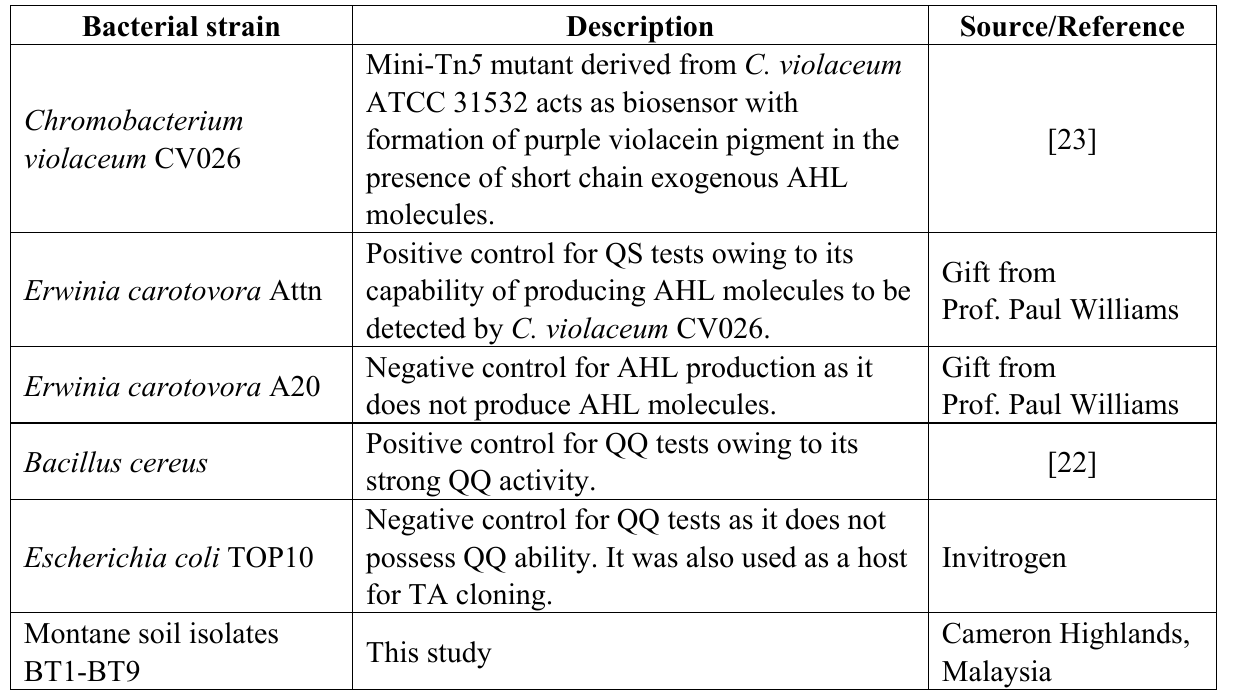
Table 1. Bacterial strains